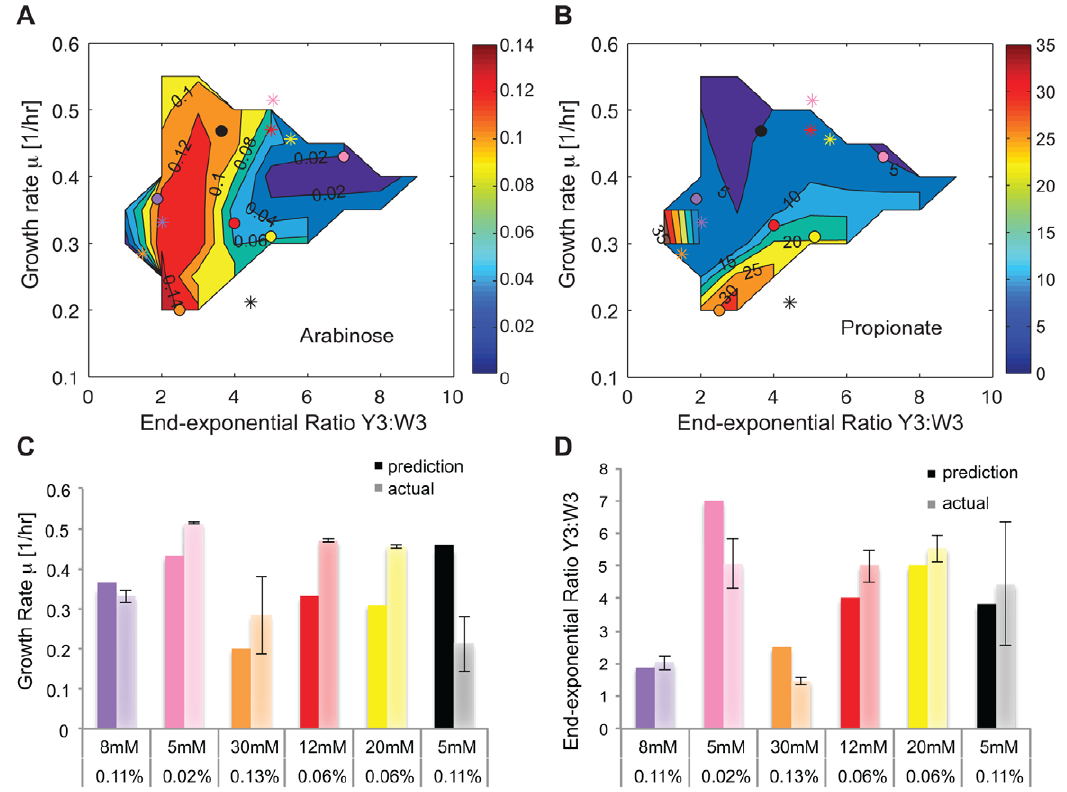
Figure 5. Design space and testing. ( A, B ) By inverting the relationships of growth rate/strain ratio vs. inducer concentrations, a design space was generated to represent the two-dimensional space of achievable growth rates and strain ratios, and to determine the arabinose ( A ) and propionate ( B ) concentrations for a desired growth rate and end-exponential ratio combination. The colored circles are ‘‘prediction’’ points and the asterisks of the same color are the ‘‘actual’’ results of using that combination of arabinose and propionate in the co-culture. The colors denote inducer combinations: purple (0.11%, 8 mM); pink (0.02%, 5 mM); orange (0.13%, 30 mM); red (0.06%, 12 mM); yellow (0.06%, 20 mM); black (0.11%, 5 mM). ( C, D ) Comparing the predicted and actual outcome for growth rate ( C ) and end-exponential ratio ( D ) in bar graph form; the predictions are in darker colors and the actual (experimental) results are in lighter ones. Error bars: 6 standard deviation. The mid-exponential ratio design space is shown in Figure S4. Experimental data are given Data S1.